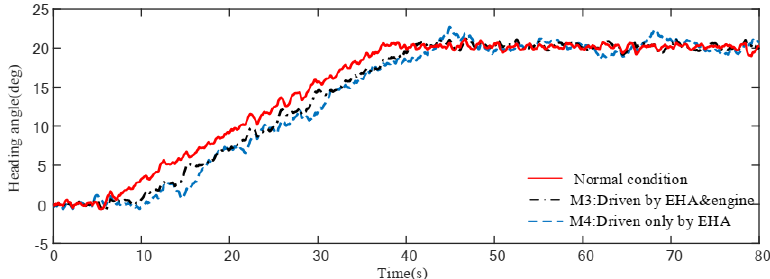
Figure 18. Heading angle response for damage scenario II under uncertainties and